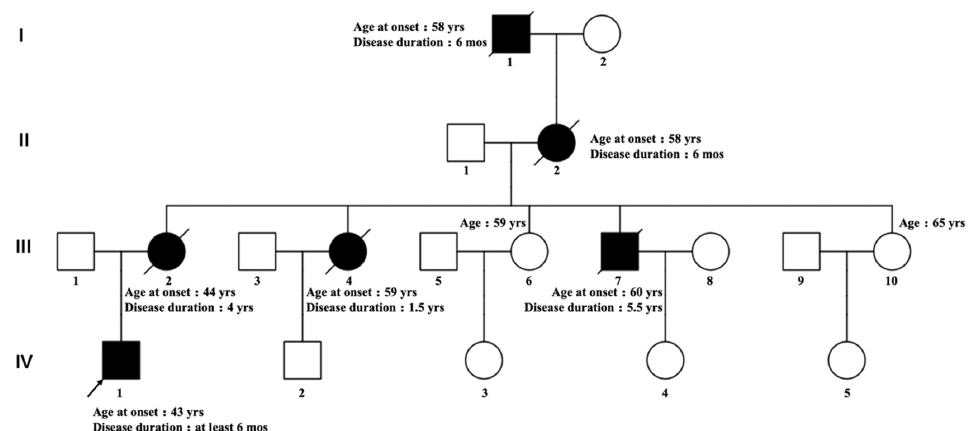
Figure 1. The pedigree of Chinese family members affected by 7-OPRI. The proband is indicated with an arrow. Black color indicates the individuals who presented symptoms of dementia. The generations are marked with numbers, with I being the first generation, II being the children of the first generation, and III being the grandchildren, and so on.